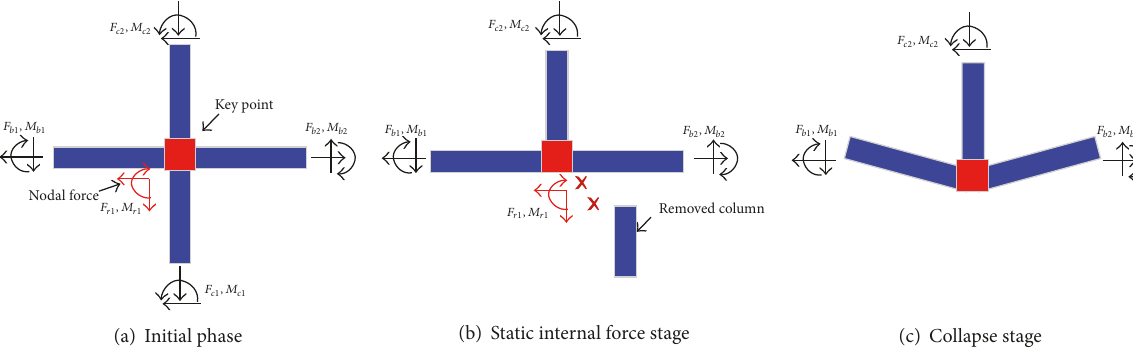
Figure 3: Element-deletion